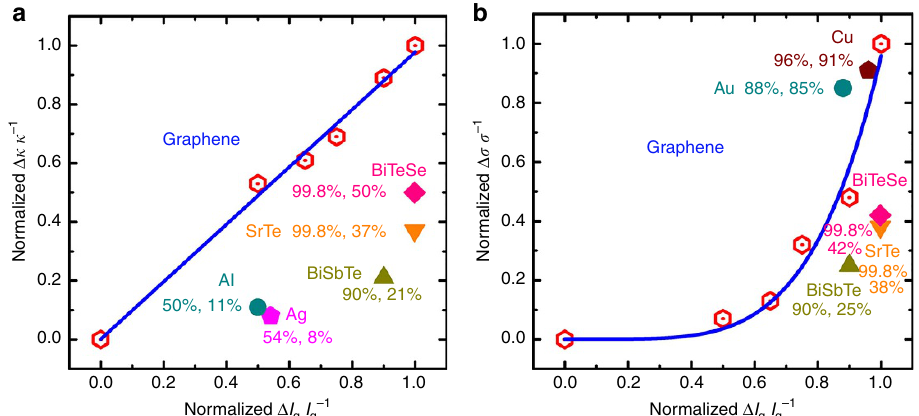
Figure 5 | Thermal/electrical conductivity change rate of graphene with grain size change rate. ( a ) Thermal conductivity change rate of graphene as a function of grain size change rate with a fit (blue curve), showing a linear relationship. ( b ) Electrical conductivity change rate of graphene as a function of grain size change rate with a fit (blue curve), showing an exponential relationship. The thermal/electrical conductivity change rates of some typical metals (Au 47 , Al 47 , Ag 48 and Cu 49 ) and semiconducting thermoelectric materials (BiSbTe 33 , SrTe 34 and BiTeSe 35 ) are also shown in different colours for